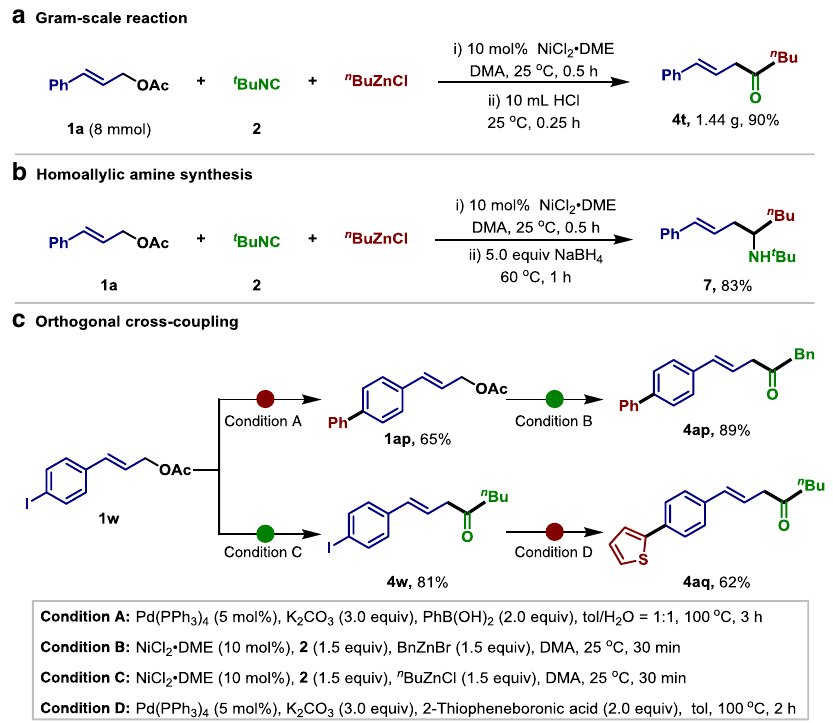
Fig. 5 Synthetic application. a Gram-scale experiment. b Synthesis of homoallylic amine. c Orthogonal